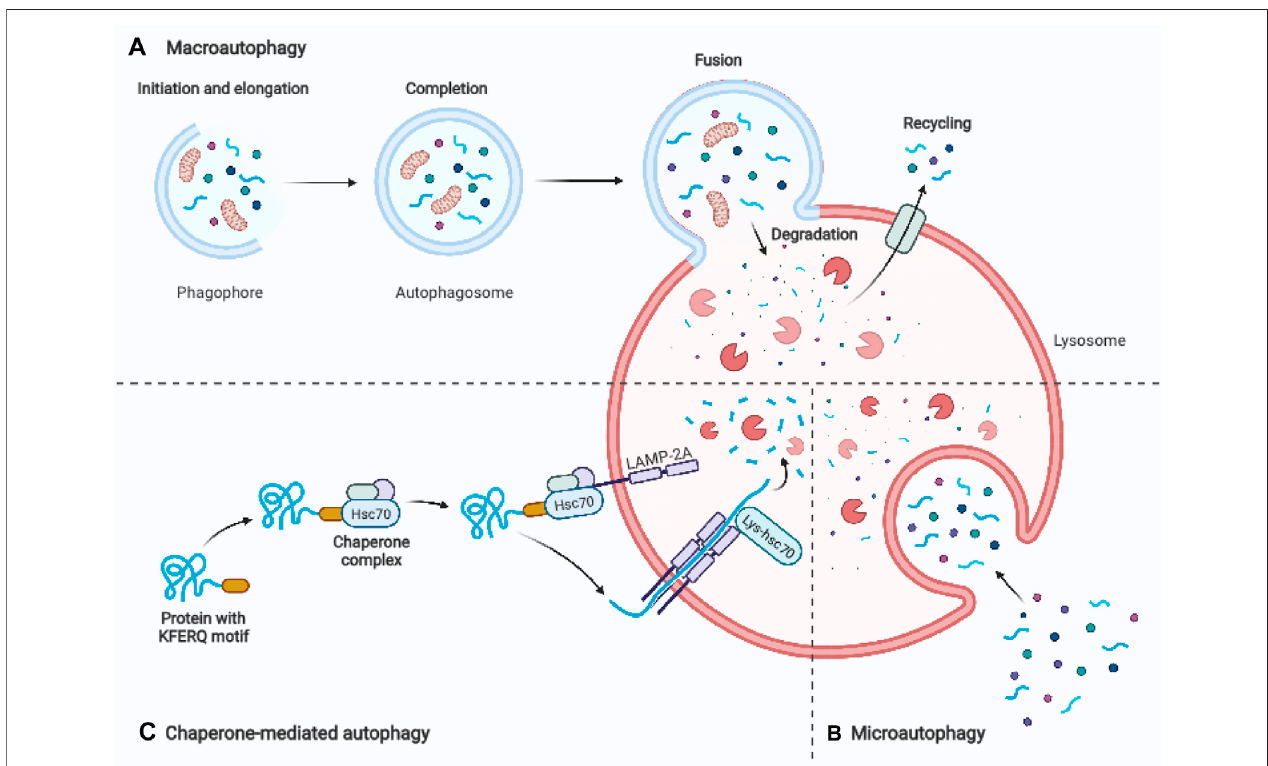
FIGURE 1 | Schematic representation of three main autophagy pathways. (A) Macroautophagy: An autophagosome is formed by enclosing a section of cytoplasm,includingorganelles,inanisolationmembraneknownasphagophore.Theautophagosome ’ soutermembranemergesthelysosome,andtheautolysosome degrades the inside material. (B) Microautophagy: Inward invagination of the lysosomal or late endosomal membrane directly engulfs small fragments of cytoplasm. (C) Chaperone-mediated autophagy: Hsc70 and cochaperones in the cytosol identify substrate proteins with a KFERQ-like pentapeptide sequence. After binding to lysosomal LAMP-2A, they are transferred into the lysosomal lumen. Adapted from biorender.com.